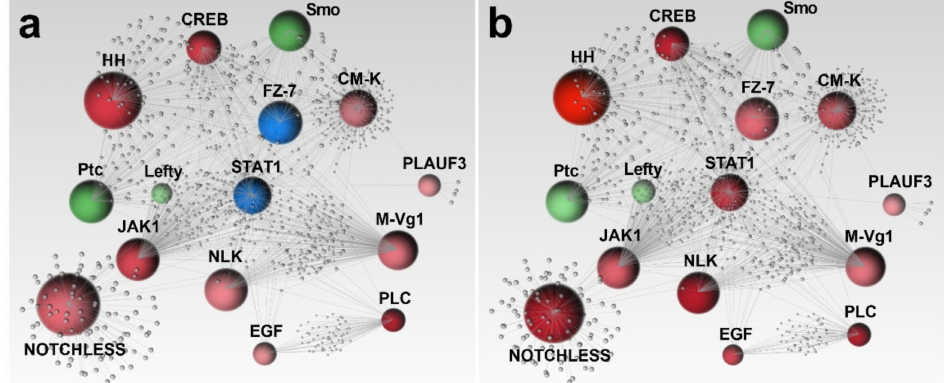
Figure 3. Gene network obtained by STRING interactome analysis of 15 genes involved in devel- opmental processes. Correlation confidence score cut-off of 400 was reported. Among functionally correlated genes, those with up (red), down (green) and unchanged (blue) expression affected by PAHs ( a ) and PCBs ( b ) were reported. Color shading depends on fold-change values. Gray spheres represent additional connections. The whole list of human orthologous genes used for Network analysis is reported in Supplementary Table